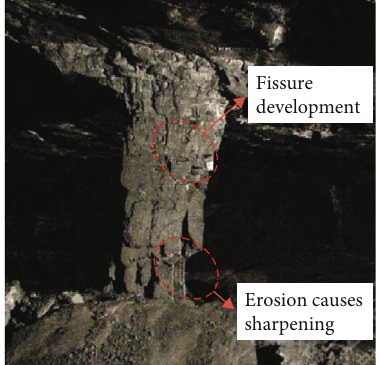
Figure 1: The mine pillar is eroded and